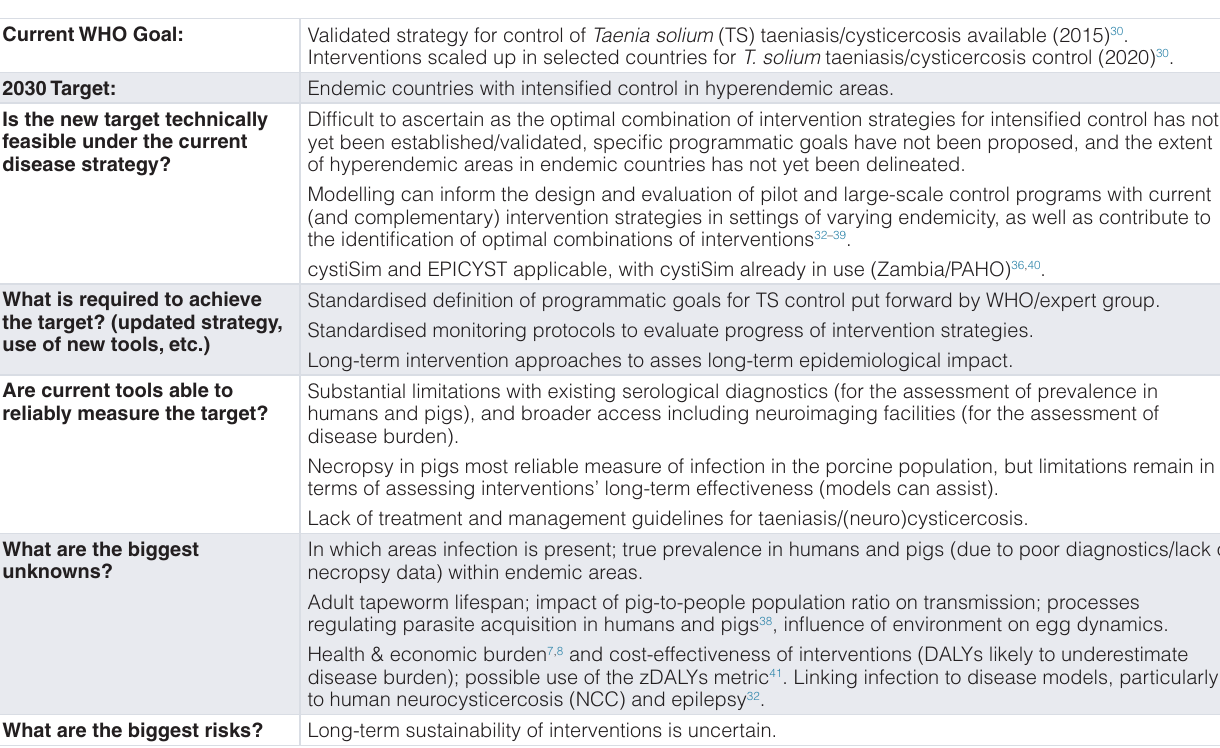
Table 1. Summary of modelling insights and challenges for reaching the World Health Organization (WHO) 2030 goals for Taenia solium taeniasis/cysticercosis. Current WHO